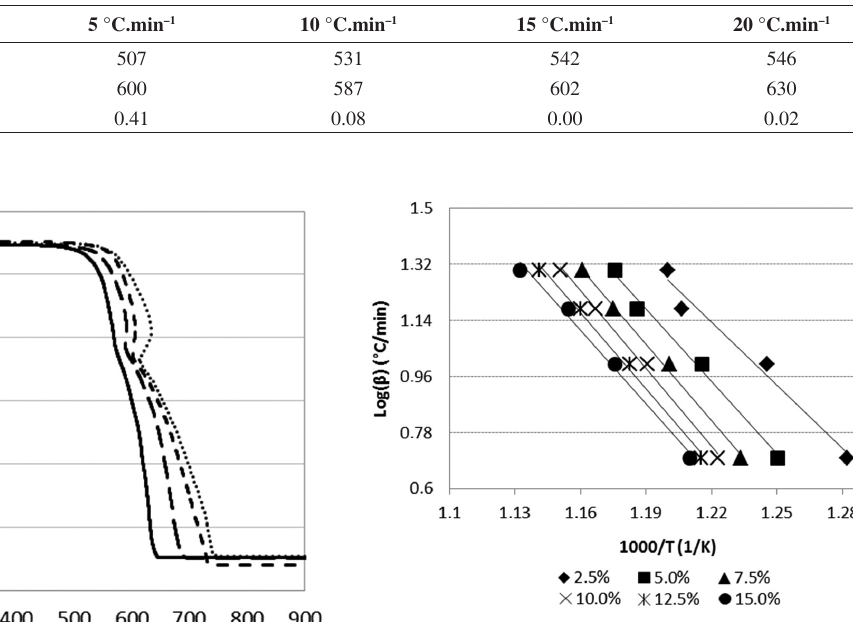
Table 4. Thermal characteristics of PEEK for the heating rates of 5 °C.min –1 ; 10 °C.min –1 ; 15 °C.min –1 and 20 °C.min –1 in air atmosphere.